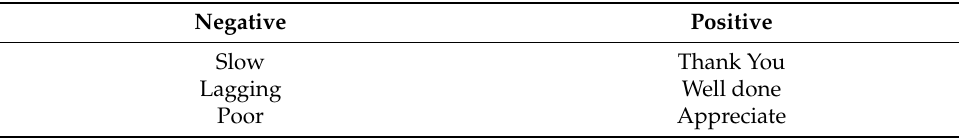
Table 2. Wordlist of labelled words.